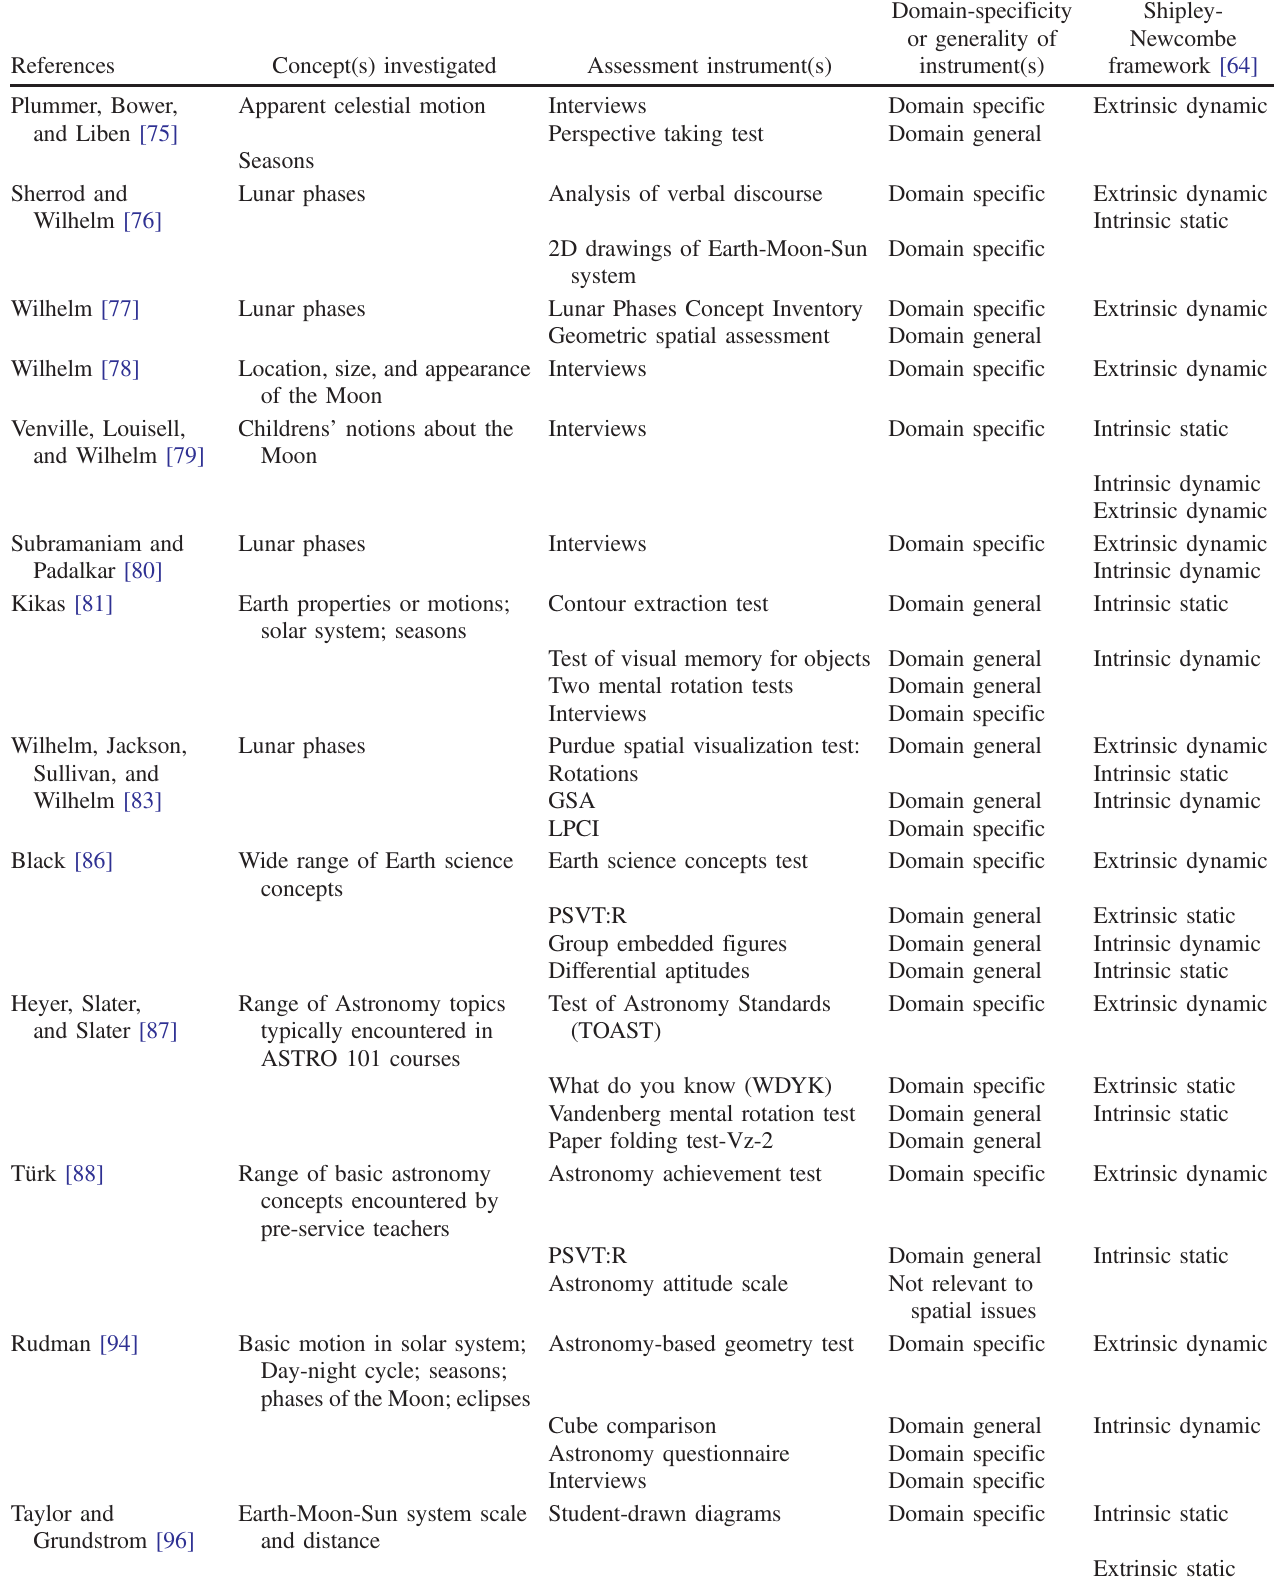
TABLE IV. Newcombe-Shipley [64] categories for noninterventional studies. Note that while the domain specificity or generality and assessment instrument columns are intended to align, any alignment with the Newcombe-Shipley framework column is